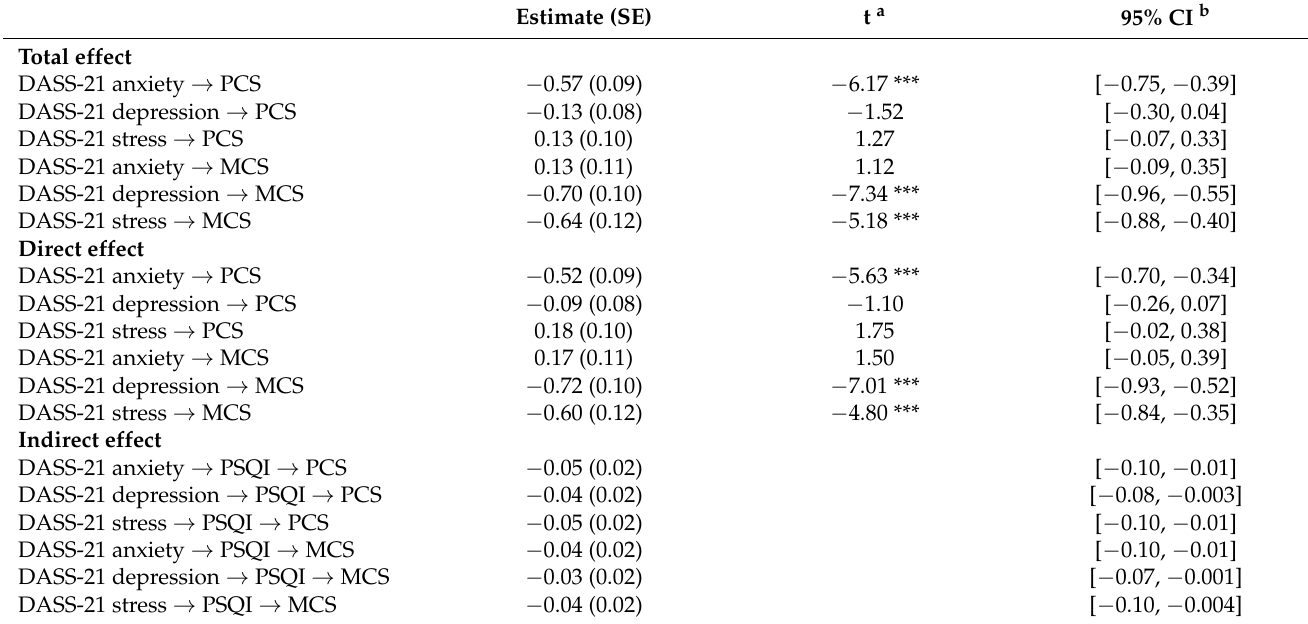
Table 4. Total, direct, and indirect effects (unstandardized estimates) of the mediation models examining the association between negative affect (anxiety, depression, and stress) and physical and mental health-related quality of life with sleep quality as